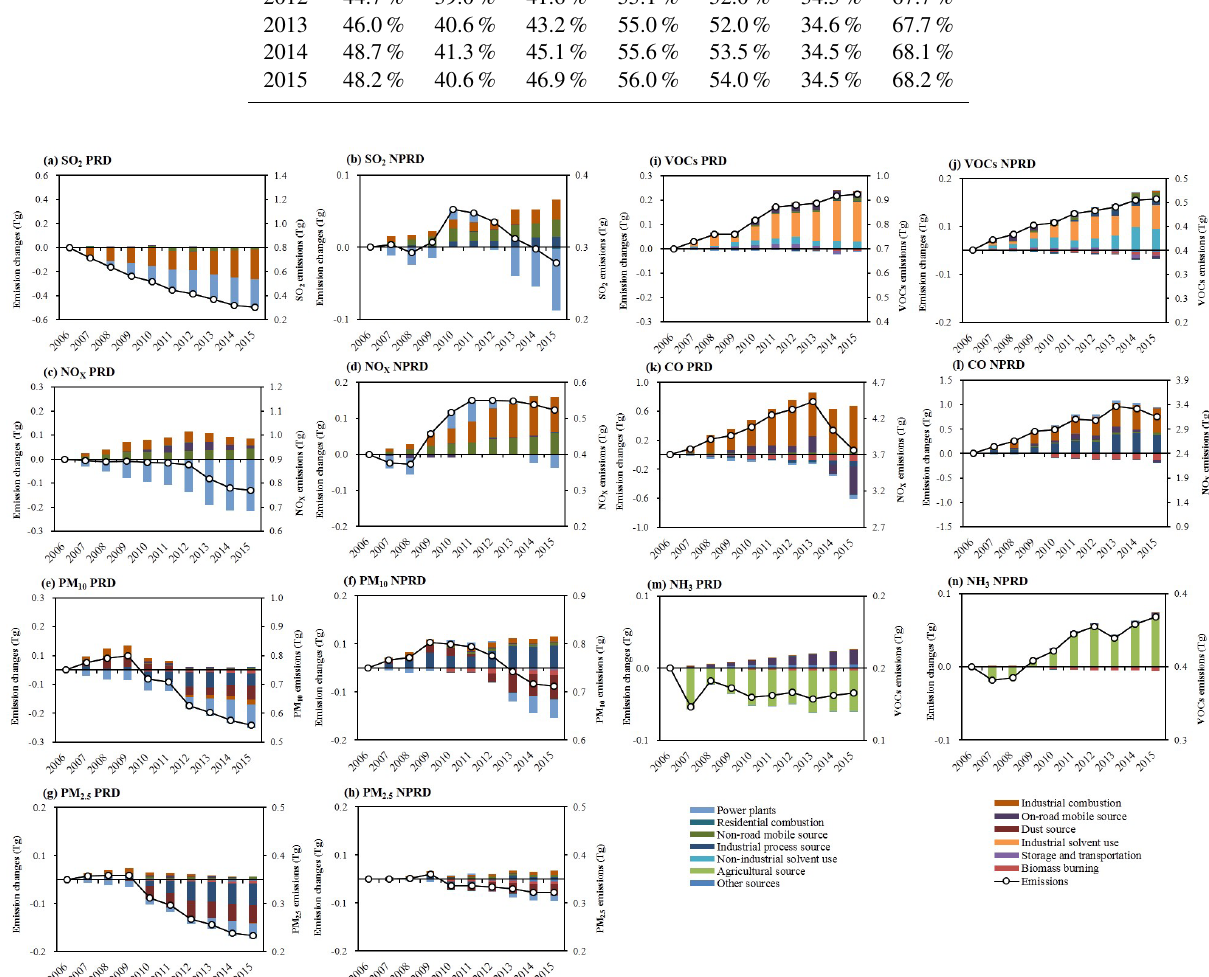
Figure 3. Emission evolutions by source categories and year in PRD and NPRD for (a) – (b) SO 2 , (c) – (d) NO x , (e) – (f) PM 10 , (g) – (h) PM 2 . 5 , (i) – (j) VOCs, (k) – (l) CO, and (m) – (n) NH 3 from 2006 to 2015. Here, the additional emissions compared to the level in 2006 are presented using a bar graph (left axis). The total annual emissions were also shown using a point plot (right axis).